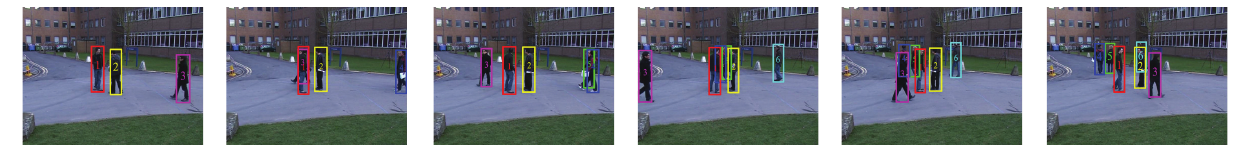
Figure 7: The typical results of S2 L1 view5 (Frame: 26, 50, 57, 83, 93, and 103).